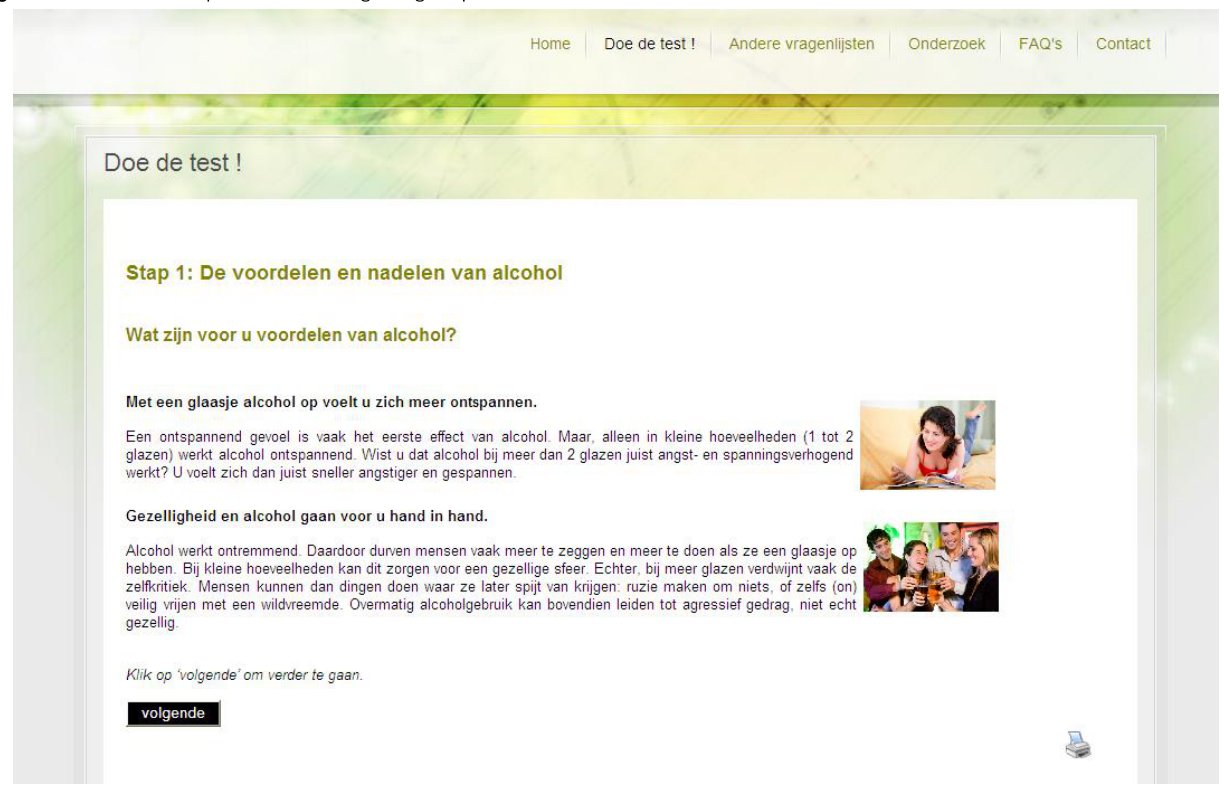
Figure 4. Screenshot of a personal advice regarding the pros of alcohol